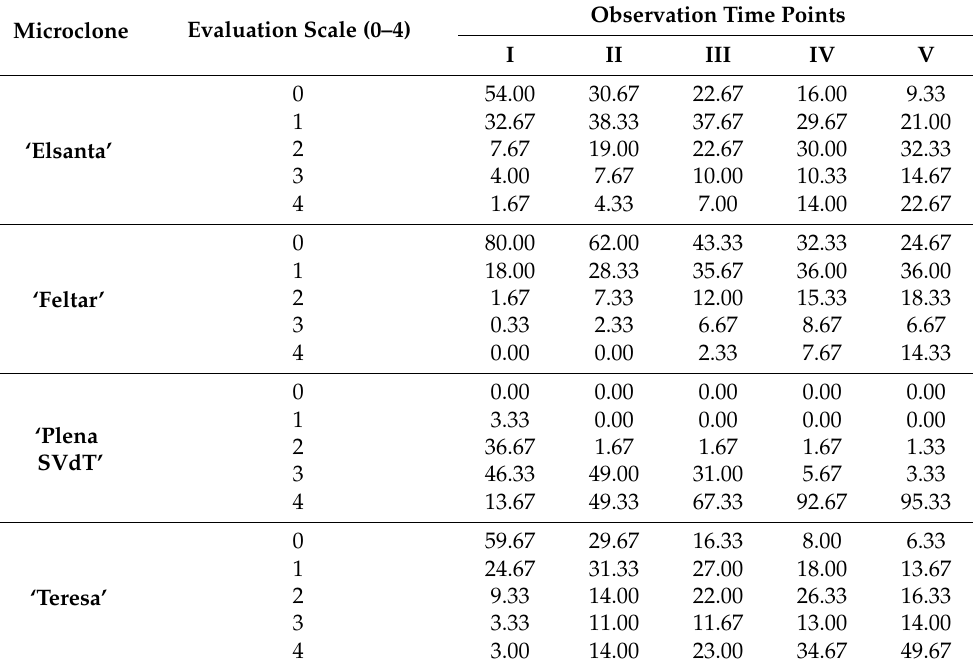
Table 2. Percentage of microplants with symptoms of Phytophthora disease among strawberry microclones at subsequent observation time points.